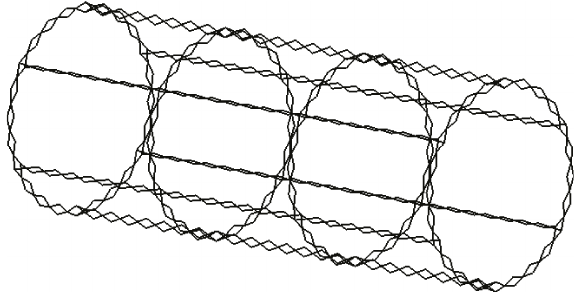
Figure 3: The deployable truss